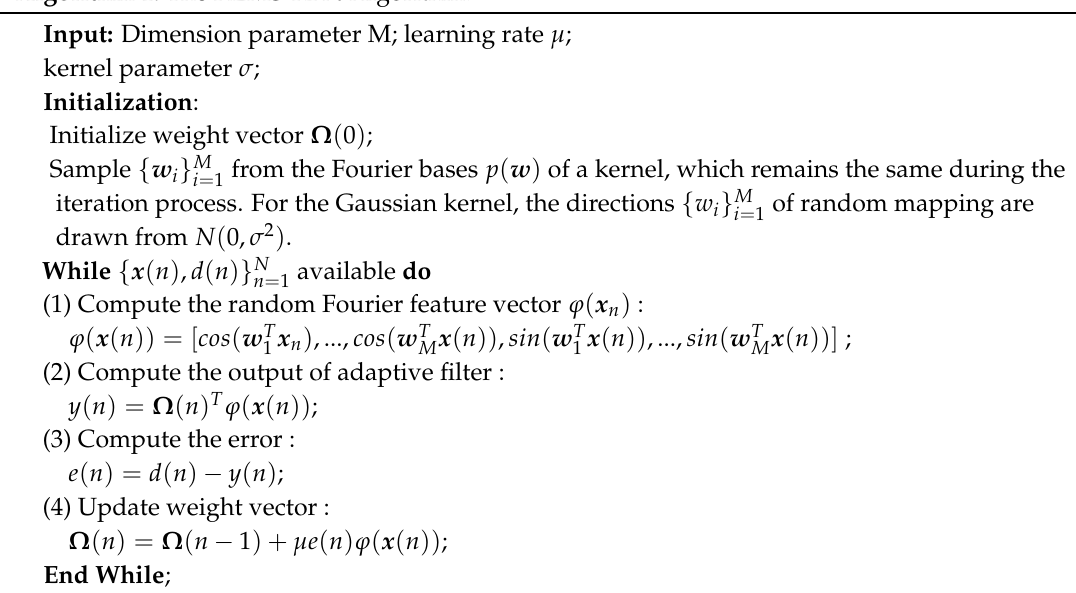
Algorithm 1: The KLMS-RFN